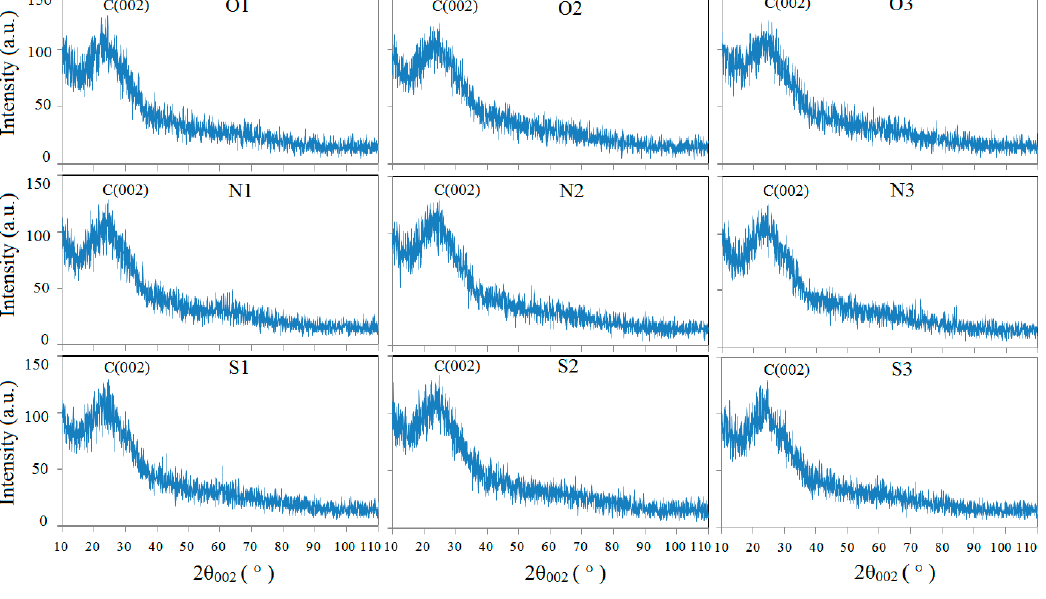
Figure 9. XRD spectra of the soot. Table 3. Characteristic parameter results of XRD analysis of the soot.